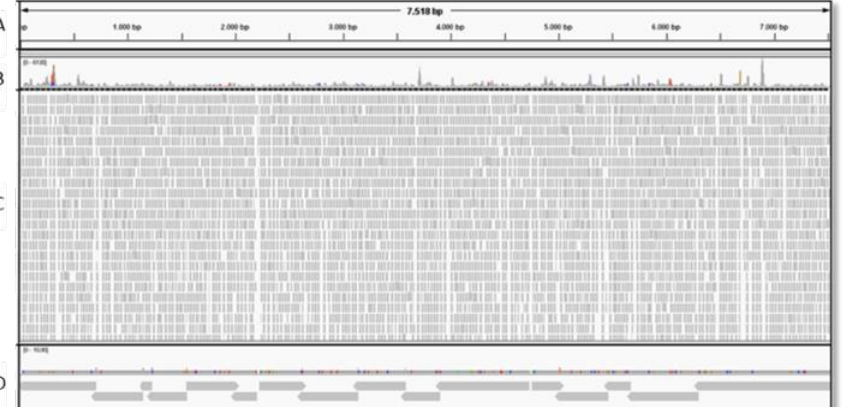
Figure 6. Visualization of the consensus alignments of citrus yellow vein clearing HU generated by both “map to reference” alignment of siRNA reads and de novo assembled contigs. ( A ) CYVCV CQ reference genome; ( B ) coverage obtained by siRNA reads alignment; ( C ) siRNA library (171,807 reads) which allowed the CYVCV-HU full genome reconstruction; ( D ) consensus obtained by alignments of 16 contigs. For the visualization the Integrative genome viewer (IGV) software has been used [47]. The presence of CYVCV was confirmed by the specific amplicons with the expected size of 921 bp of the 5 (cid:48) region [22] (Figure S1A). Inoculation of the source HU-PSTS on sour orange and lemon revealed the typical clearing of lateral leaf veins, yellow flecks, and transient ring-spot-like symptoms on spring and autumn flushes, leaf crinkling and warp- ing, and browning of the midribs described for the citrus yellow vein clearing disease [58] (Figure 7).